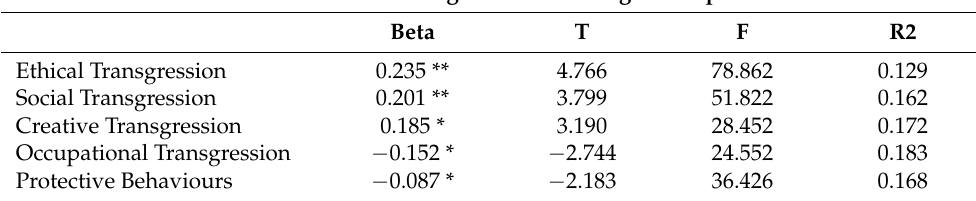
Table 2. Regression analysis of the Transgression dimensions which explain Readiness to Exchange Views on Religious Topics (N =